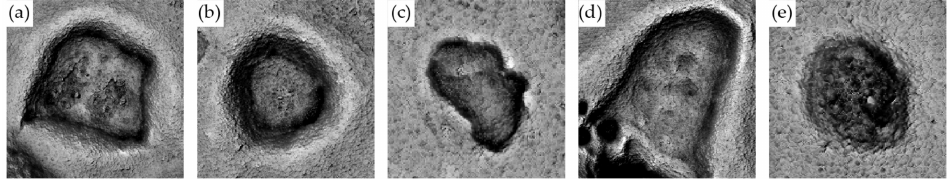
Figure 6. Various aguadas and water reservoirs as evident in a 0.5 m resolution VAT. The scale varies.